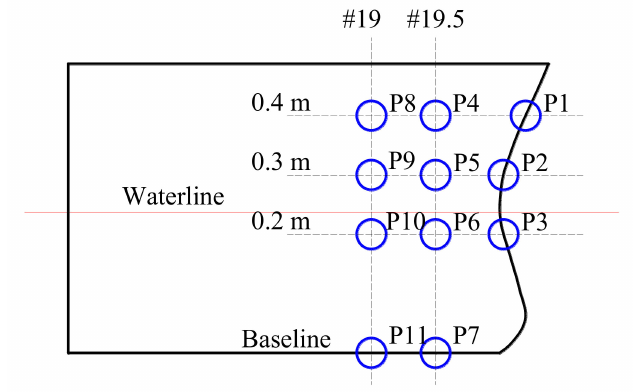
Figure 4. Arrangement of pressure